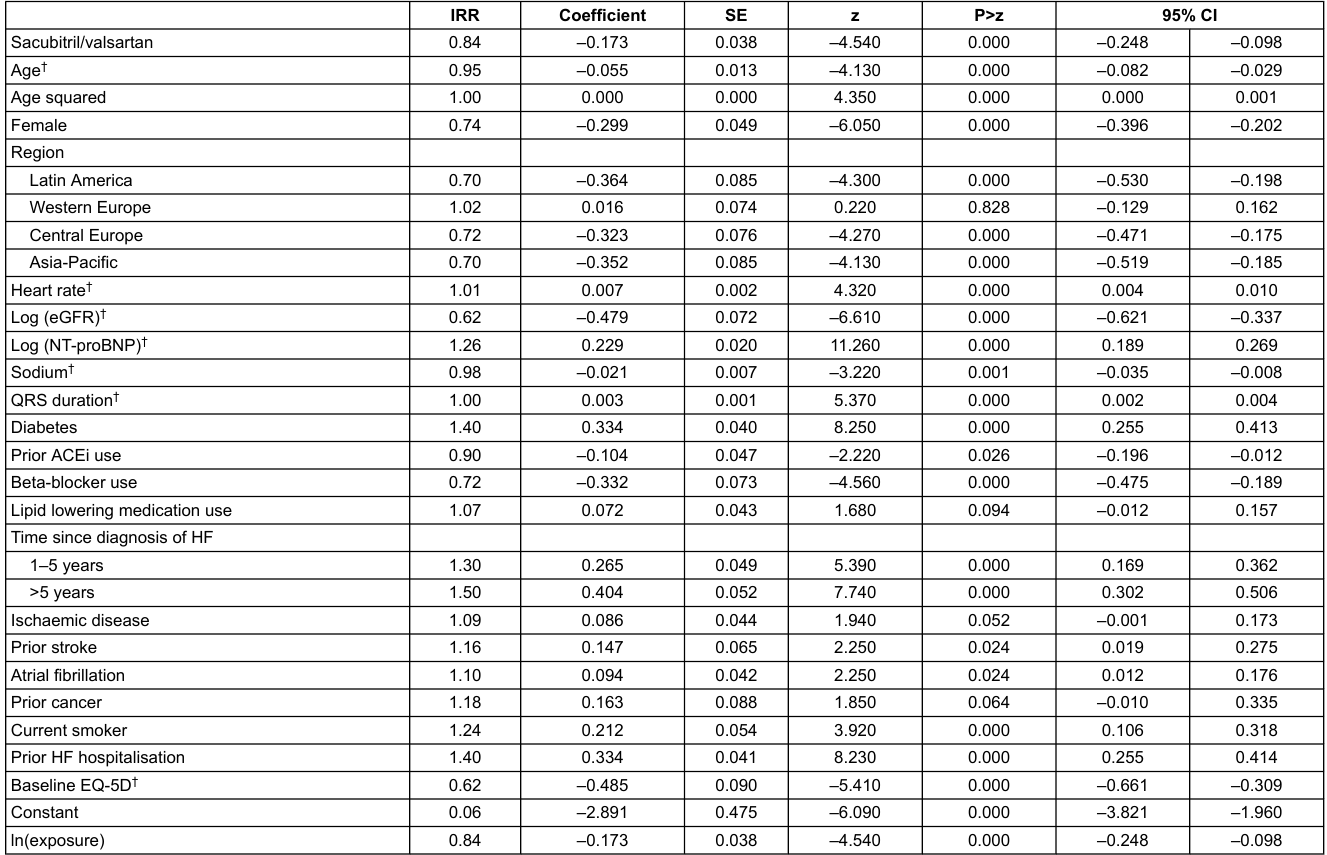
Table S7: Negative binomial regression model for all-cause hospitalisation.